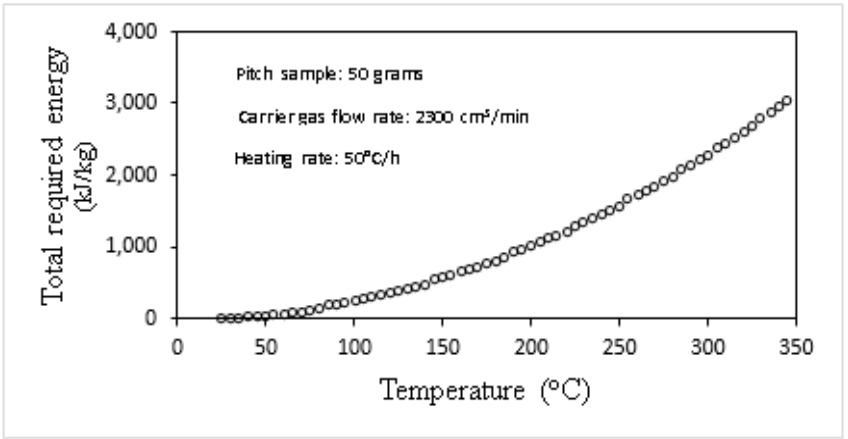
Figure 17. Total required energy in first step of carbonization (25–350 °C) of a 50 g CTP sample ◦ C/h and carrier gas flow rate: 2300cm 3 φ i s: 1, heating rate: 50